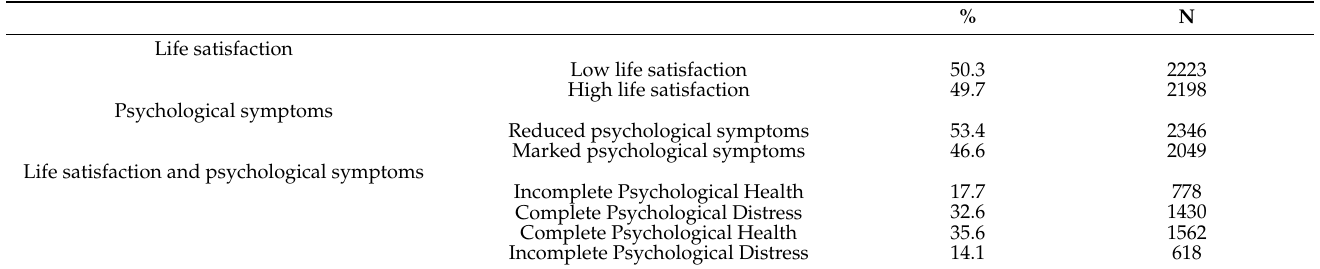
Table 3. Life satisfaction and psychological